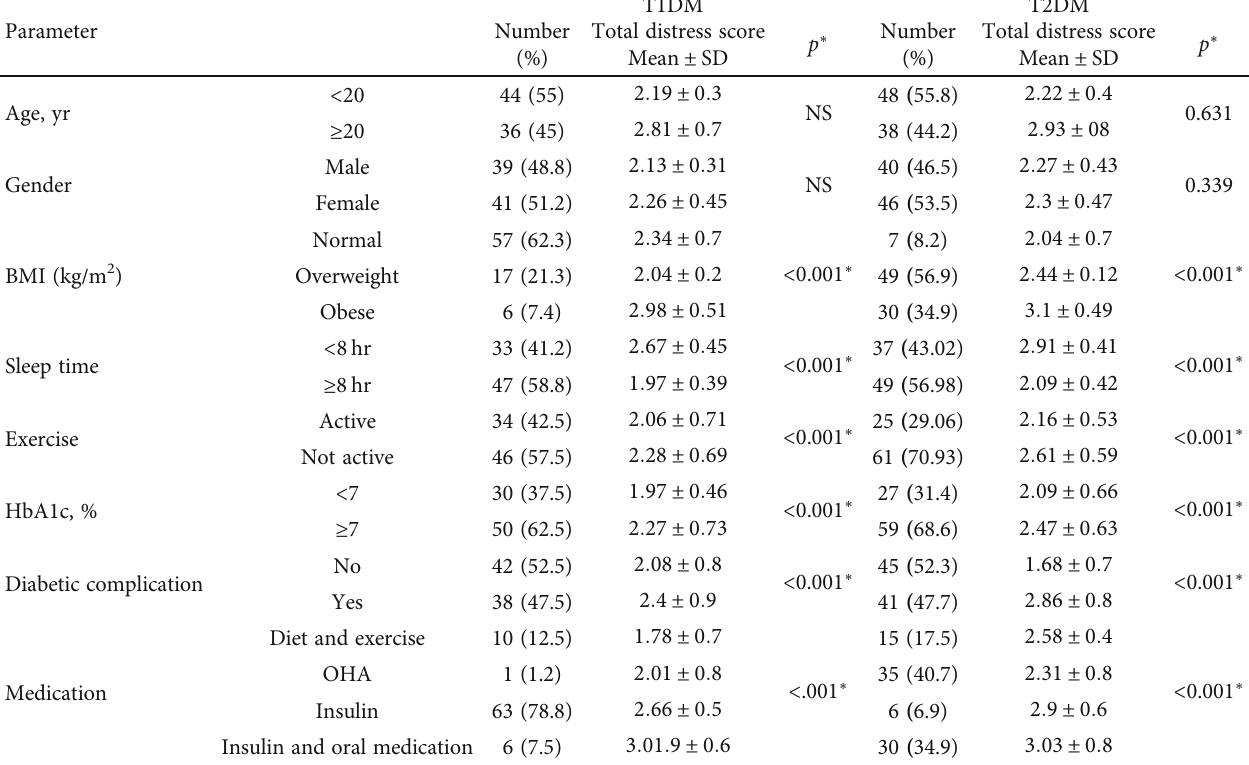
Table 2: Sociodemographic and clinical parameters and level of diabetes